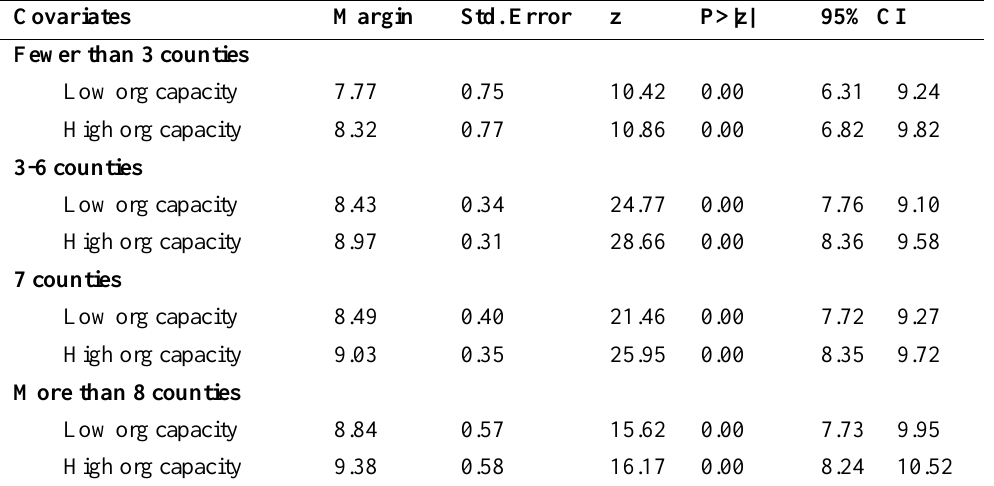
Predicted values based on results from model 4, Table 5, with all model variables held at their mean values. Low organizational capacity <= sample mean of 26 staff and board members; High organizational capacity>26 staff and board